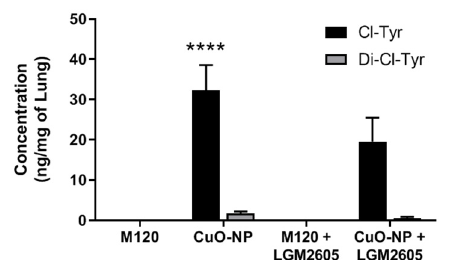
Figure 7. CuO-NP-induced protein chlorination in murine lung. Determination of mono-chlorotyrosine and di-chlorotyrosine in murine lung as determined by LC-MS/MS. All data are presented as the mean ± the standard error of the mean. Asterisks indicate a statistically significant difference from M120 (**** p < 0.0001).